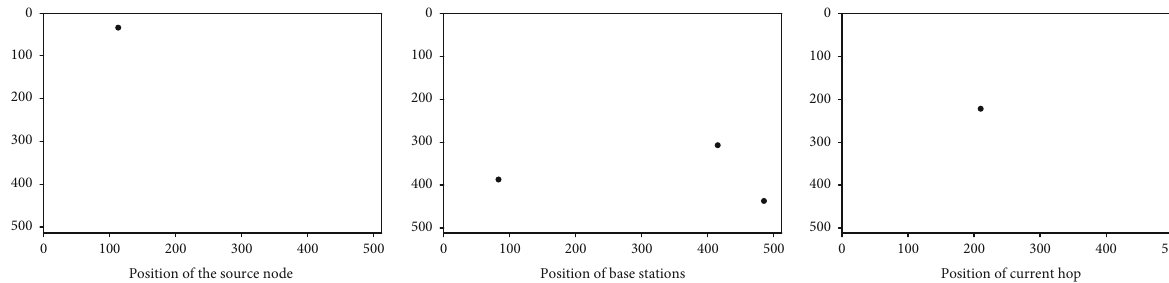
Figure 6: Positioning of the source node, base stations, and the node that the packet is currently at.